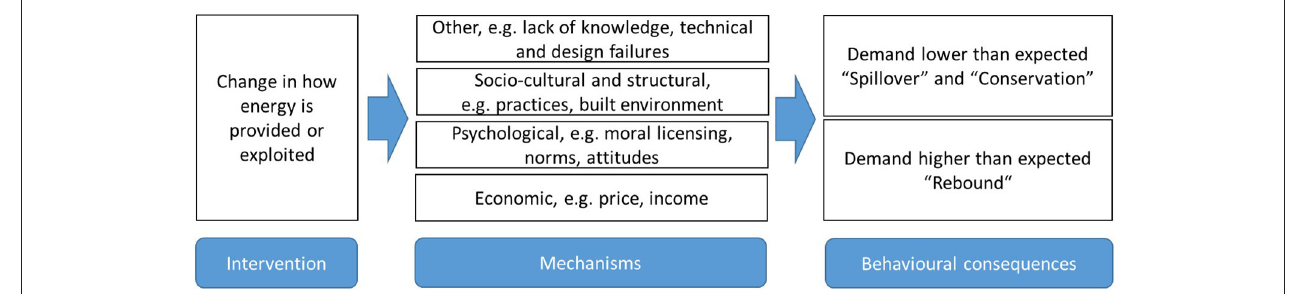
FIGURE 2 | Schematic overview of potential behavioral effects and underlying mechanisms of efficiency increases. Own figure further developed from Dütschke et al.